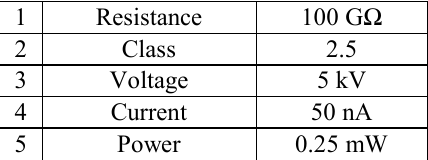
Table 1. Parameters of the reference resistor